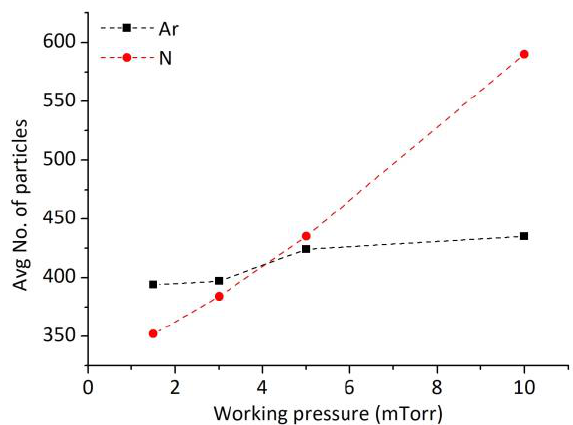
Figure 14. Summary of mean average number of simulated particles reaching the substrate after being sputtered using Ar (black) and N (red) at different working pressures in GLAD configuration.